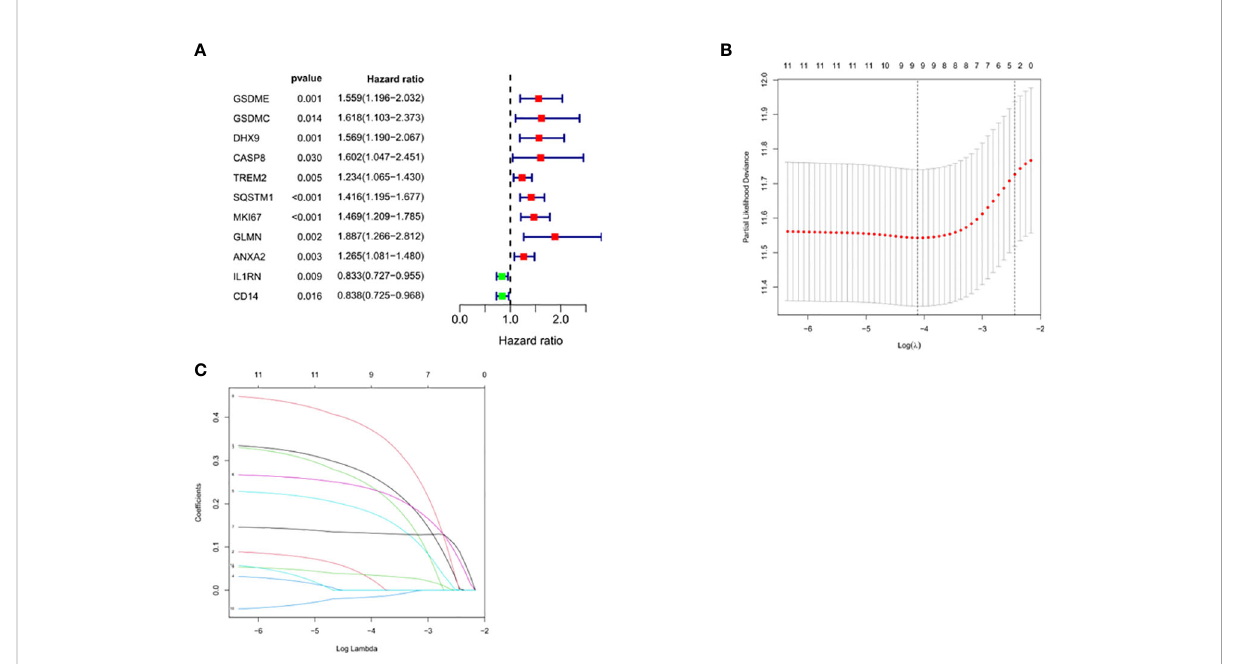
FIGURE 5 Selection of prognosis-related DEGs in TCGA cohort. (A) Univariate Cox regression analysis. (B, C) LASSO regression analysis.